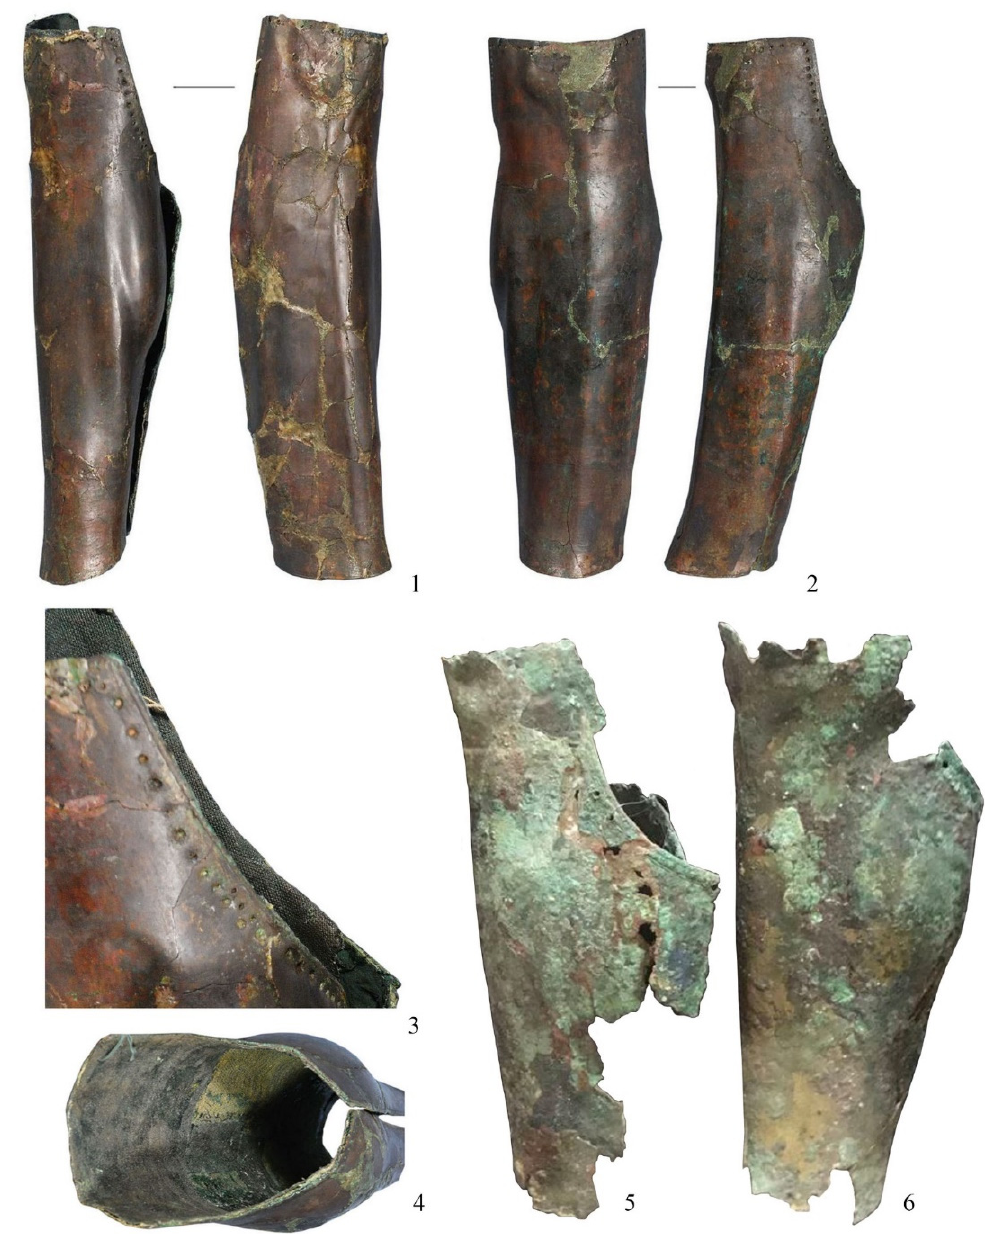
Figure 14. Greaves from Scythian kurgans with cut knee pads. (1)–(4)—Steblev Barrow 3, Burial 2 (photograph Т . Kurgina-Kovalenko); (5)–(6)—Illinka Barrow 4, Burial 2 (photograph A. Figure 13. Greaves from Scythian kurgans with cut kneepads. (1)–(4)—Steblev Barrow 3, Burial 2 (photograph Т . Kurgina-Kovalenko); (2)–(6)—Illinka Barrow 4, Burial 2 (photograph А . А ntonov).